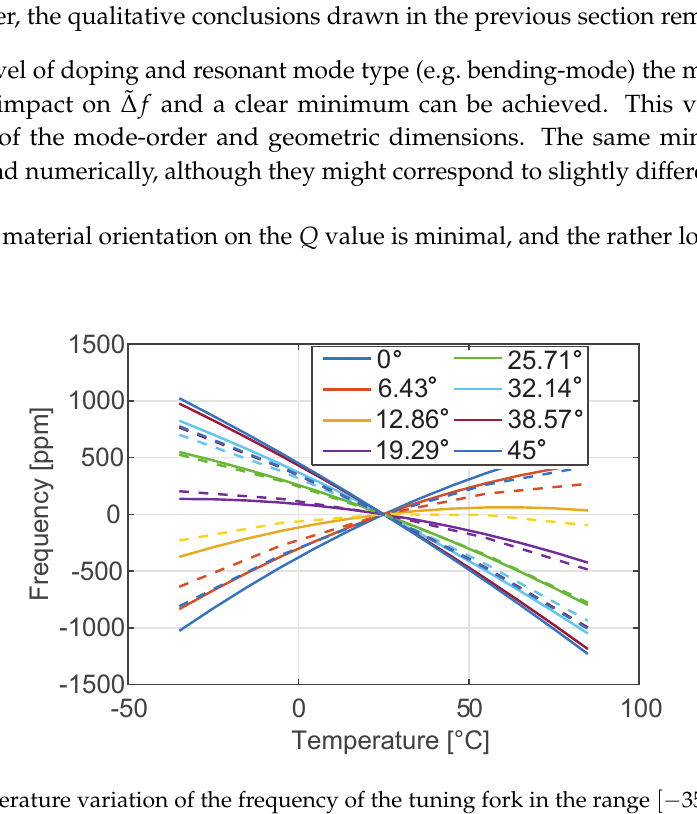
Figure 7. Temperature variation of the frequency of the tuning fork in the range [ − 35 ◦ C–85 ◦ C] for different orientations of the device with respect to the silicon wafer. Dotted lines denote numerical results, while continuous lines represent the analytical solution shown in Figure